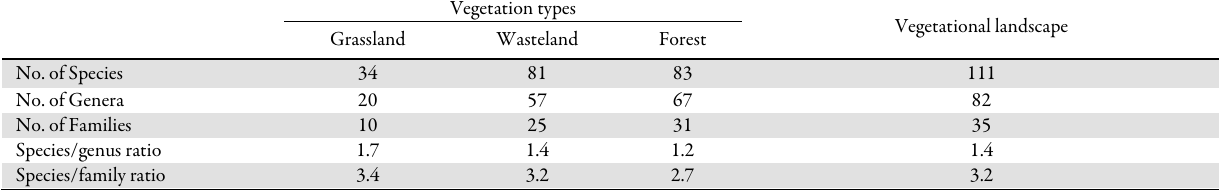
Table 1. The number of species, genera and families of climbers and their ratio across the terrestrial landscape of north-eastern Uttar Pradesh Vegetation types Vegetational landscape Grassland Wasteland